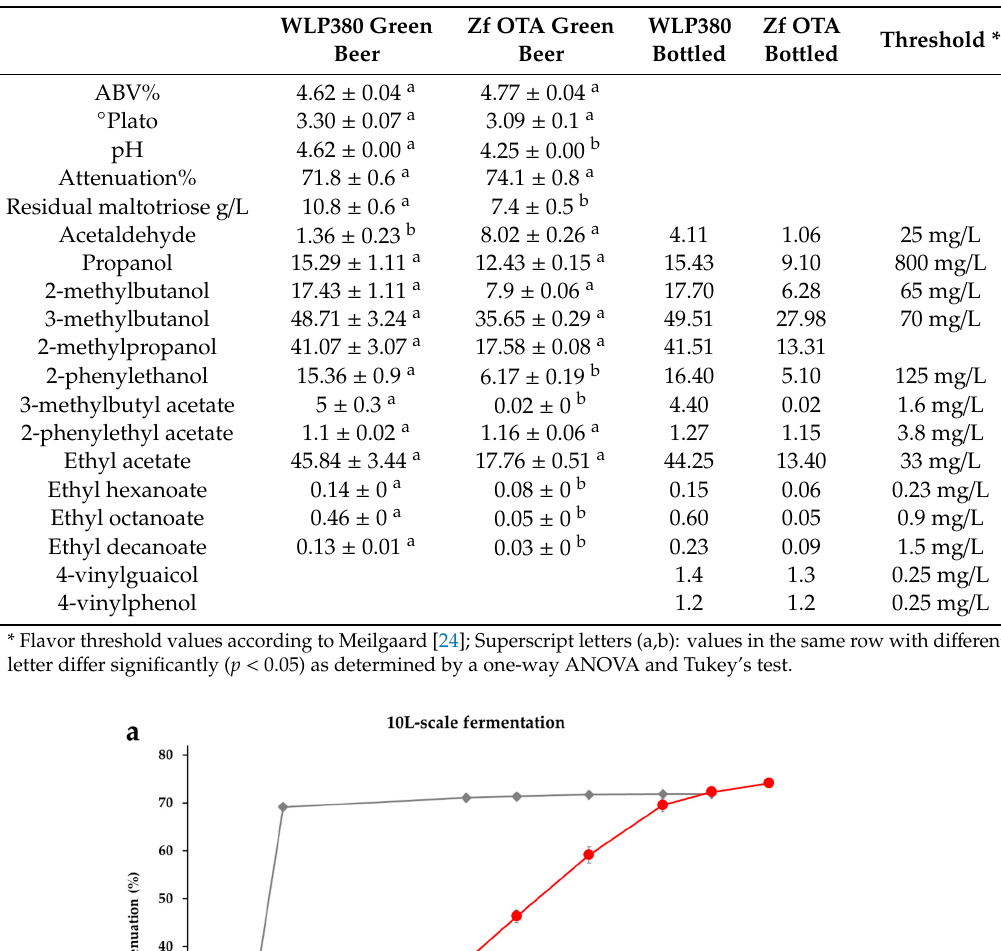
Table 3. 10 L-scale fermentation results. Green beer, (i.e., the beer after the primary fermentation, but prior to the maturation step) values are the means of duplicate-fermentations; prior to bottling, duplicates were combined and the results are means of technical replicates.